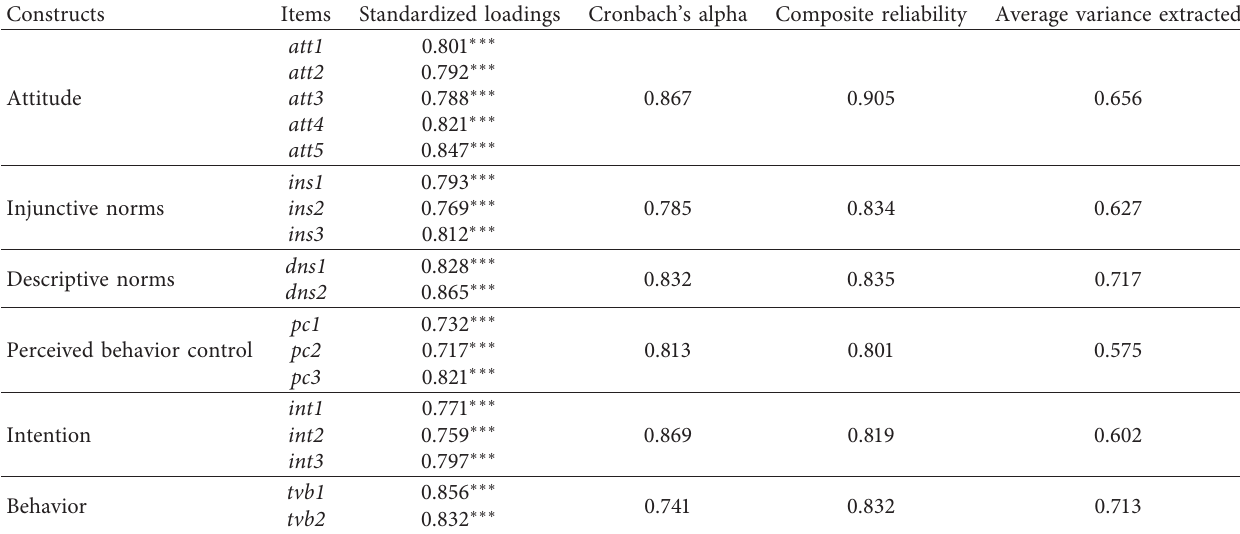
Table 5: Reliability and validity analysis of measured model.